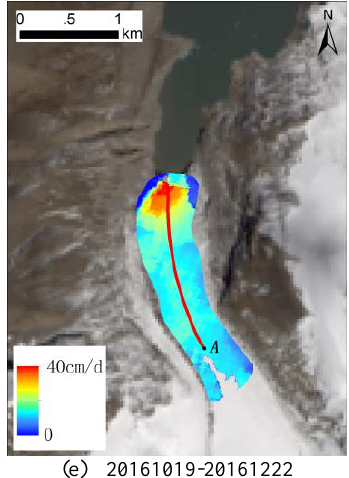
Figure 2. Velocity maps of Shie glacier